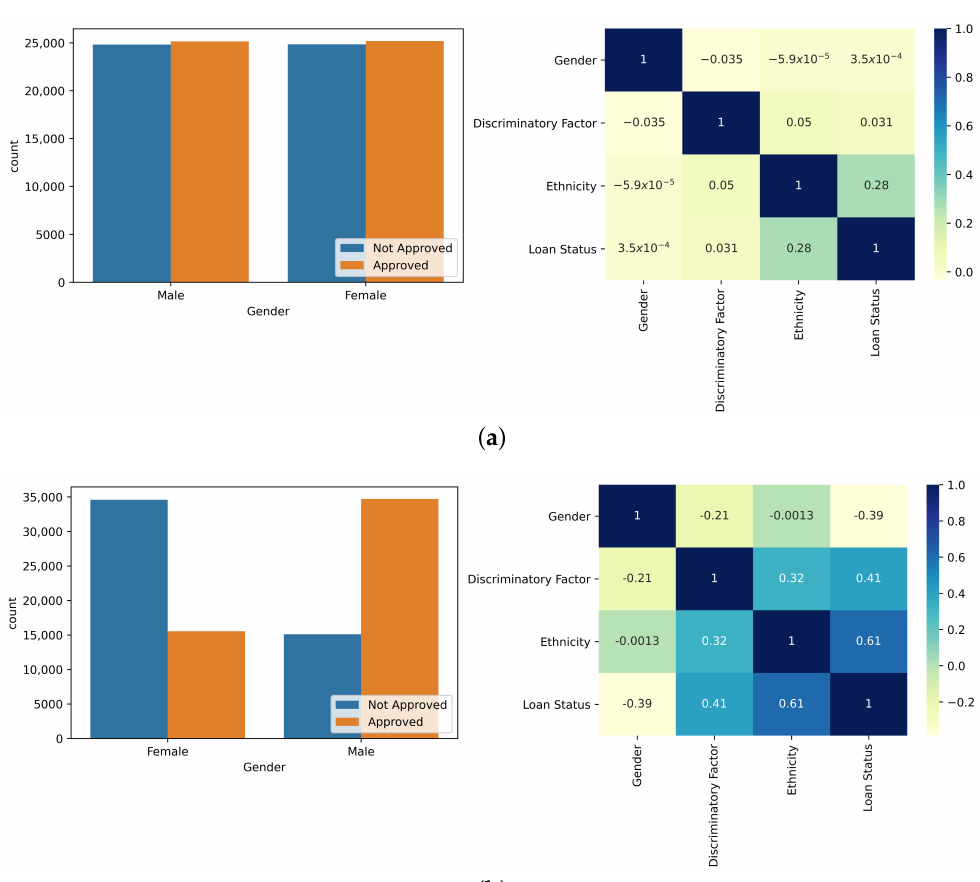
Figure 8. Impact of edge weight for nodes connected to node “Discriminatory Factor”: when the nodes are weakly connected (top half), the generated dataset is fair with regard to attribute “Gender”. Vice versa, when nodes are strongly connected, demographic parity is not respected and the generated dataset discriminates the “Female”. ( a ) Gender histogram and respective heat-map of attributes connected to it with edge weight equal to 0.1. ( b ) Gender histogram and respective heat-map of attributes connected to it with edge weight equal to